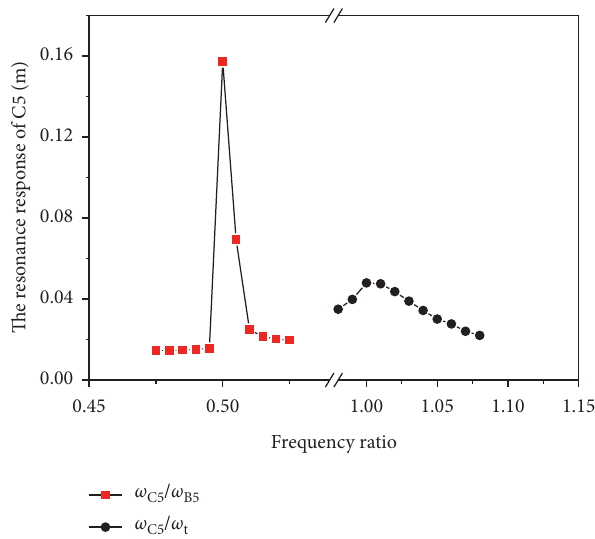
Figure 15: The relationship between frequency ratio and the maximum response of C